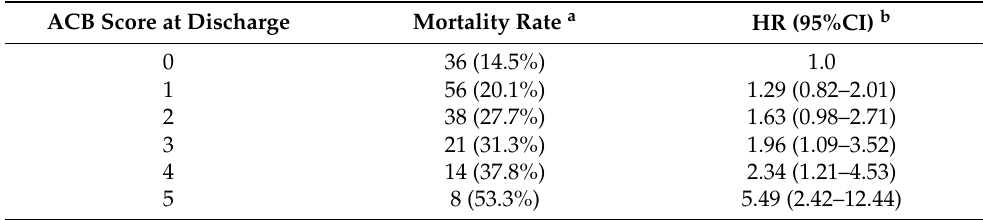
Table 3. Cox regression analysis exploring dose-response relationship between ACB score and mortality in the whole study population.